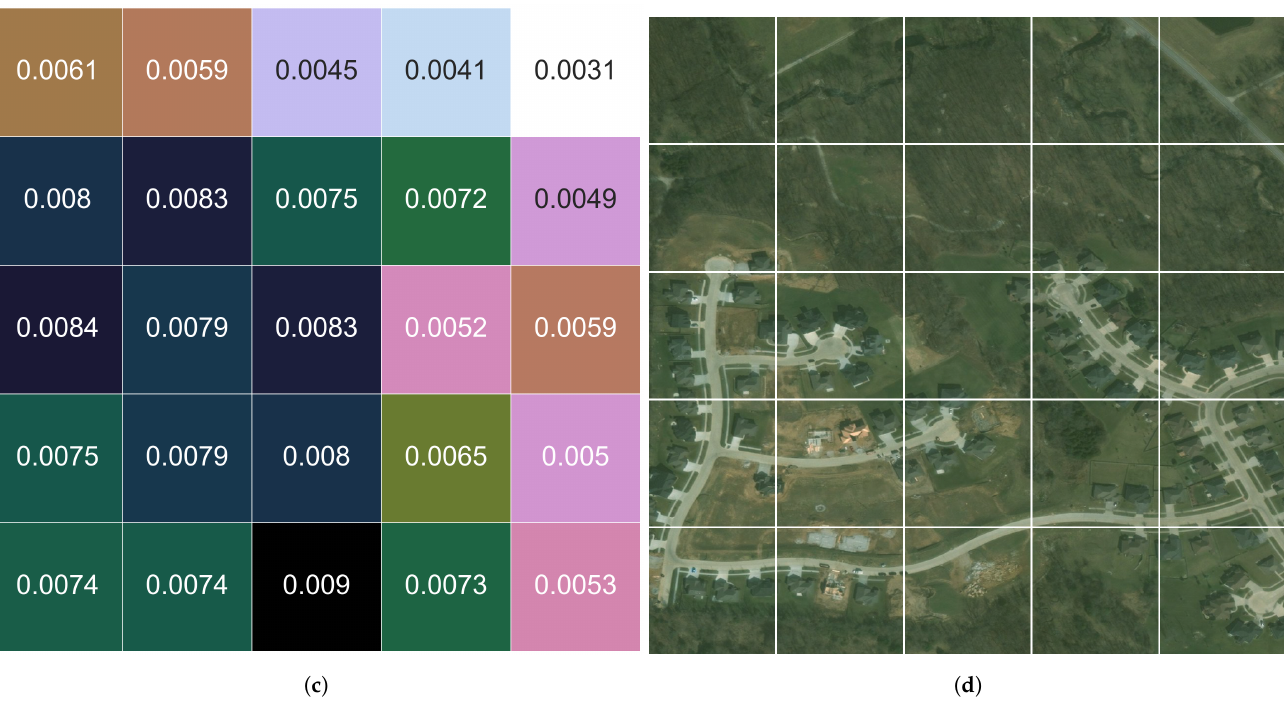
Figure 12. Comparison of change in a sub-area (5 × 5 chip) during the time period 2015–2017 utilizing (1-N) neighborhood method: ( a ) imagery (ground truth) sample from 2015; ( b ) norm2 change metrics; ( c ) JSD change metrics; ( d ) image (groundtruth) sample of 2017. The new construction—removal of trees along with the addition of road and houses— represents ground-truth visual change that measures higher than the surrounding areas, which are less impacted by the change